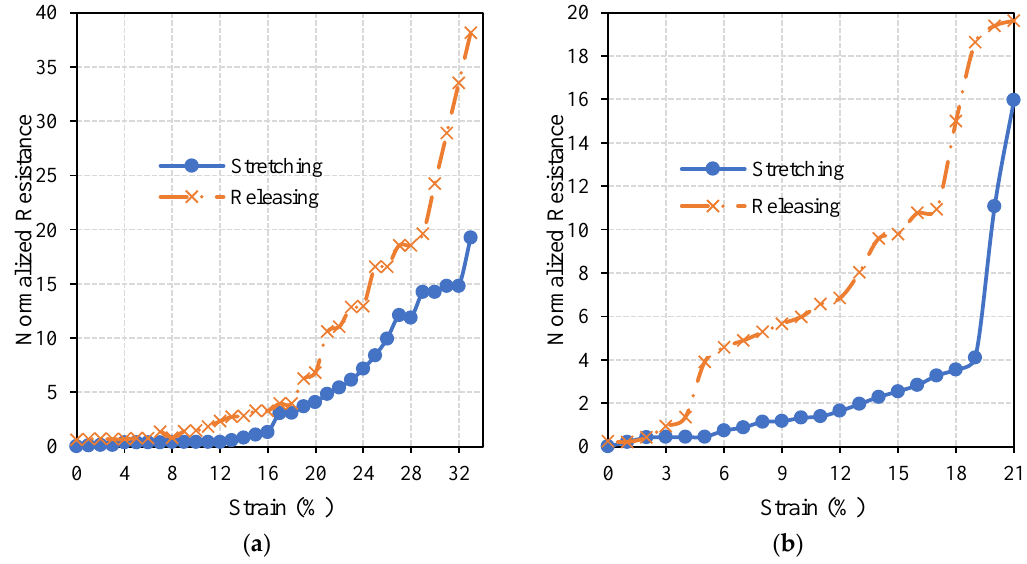
Figure 9. The change in the normalized resistance of the straight line printed on a radially pre-stretched circuit by 27% under ( a ) axial, and ( b, ) radial loads.